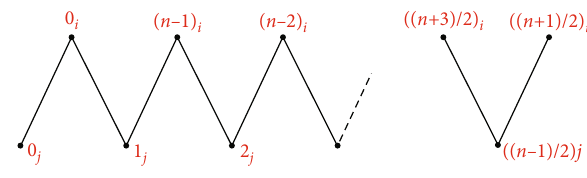
Figure 10: The labelling for ð P